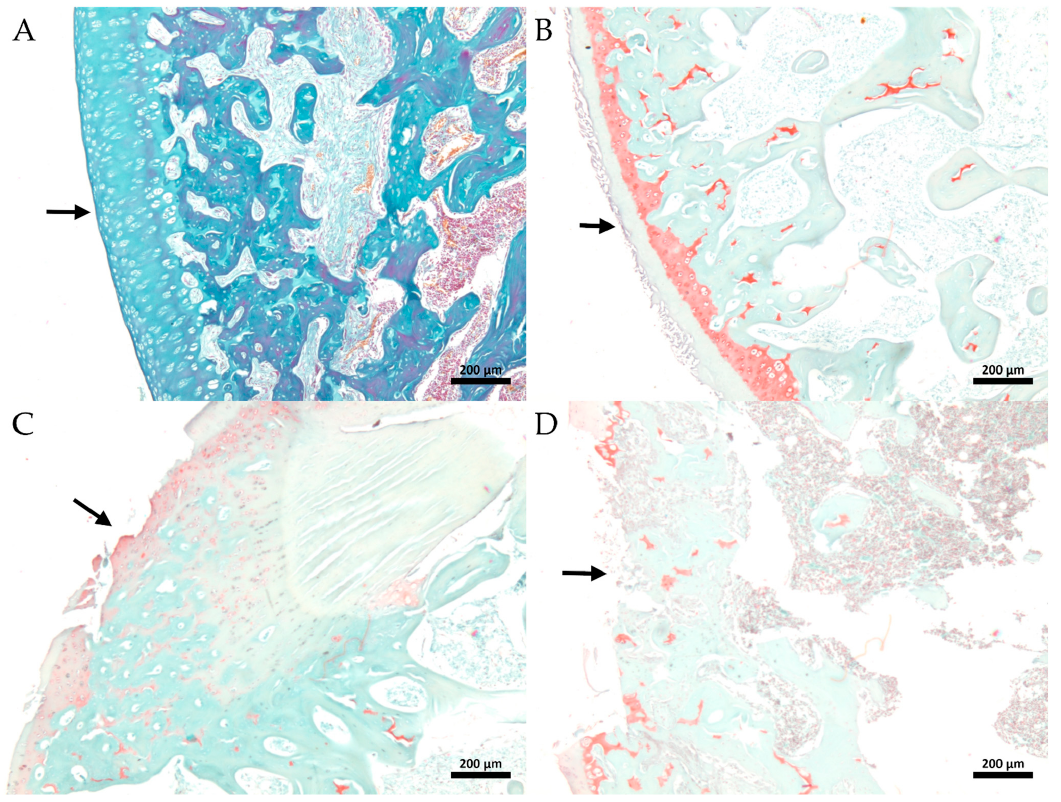
Figure 6. summary of the Osteoarthritis Research Society International (OARSI) cartilage histopathology evaluation systems in different animal groups. Panel ( A ) depicts the sham group with normal cartilage width, classified as grade 0. Panel ( B ) shows an animal from the cuminaldehyde group with moderate degeneration, classified as grade 3. Panel ( C ) shows an animal from the indometacin group with erosion to the calcified cartilage extending to approximately 75% of the articular surface, classified as grade 4/5. Panel ( D ) shows an animal from the saline group with processes of microfracture, repair, and bone remodeling, classified as grade 5/6. The cartilage matrix was stained with Safranin-O, and the original magnification was 50x. The bar represents 200 µm. The arrow indicates the surface face of the articular cartilage.